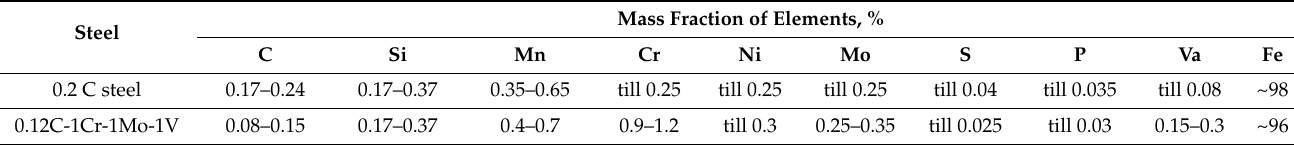
Table 1. Chemical composition (wt.%) of the investigated steels. Mass Fraction of Elements,